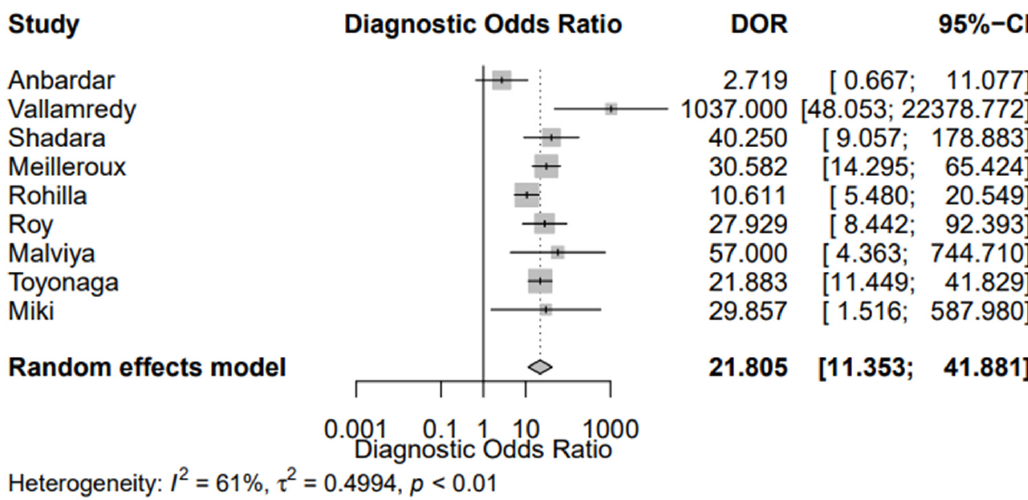
Figure 4. Diagnostic Odds Ratio (DOR) of the eligible studies using conventional cytology.